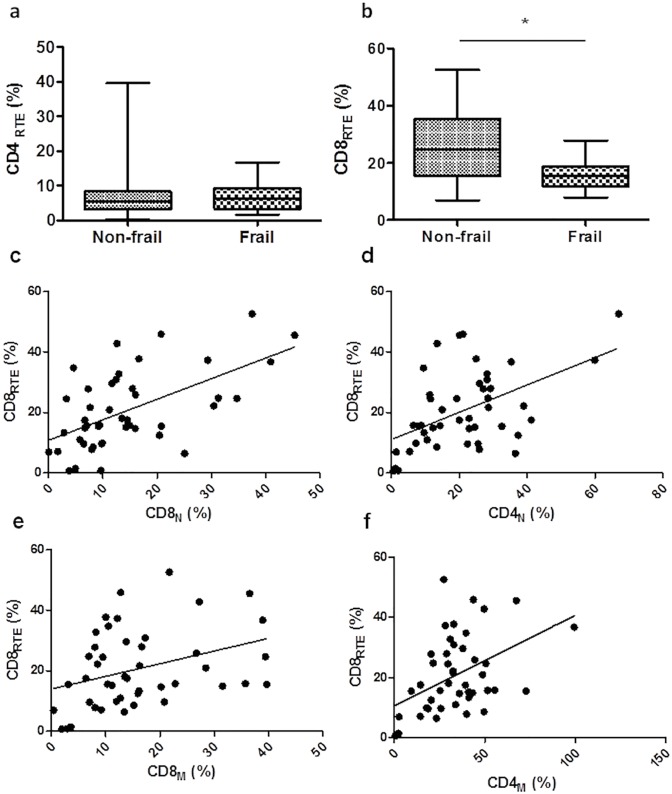
Reduction of the CD8RTE cells in frail compared to non-frail groups.PBMCs were assayed by flow cytometry by first gating on the total mononuclear cells and then on the CD3+ T cells. The frequencies of CD4RTE (a), and CD8RTE (b) were then determined. Box plots represent median with 25th and 75th percentile borders, error bars represent 10th and 90th percentile. The mean ± SEM for each group is given below the bar for that particular group. Positive correlations between CD8RTE (%) and CD8N (%) (c), CD4N (%) (d), CD8M (%) (e), and CD4M (%) (f). *p<0.05.